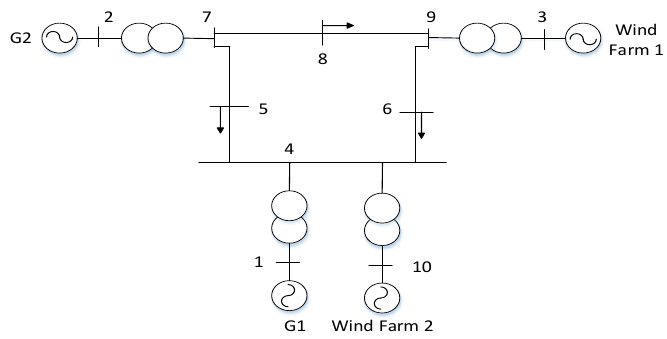
Figure 3. WSCC three-machine nine-bus system with wind turbine. Table 1. The optimal results of DFIG damping control in WSCC system.